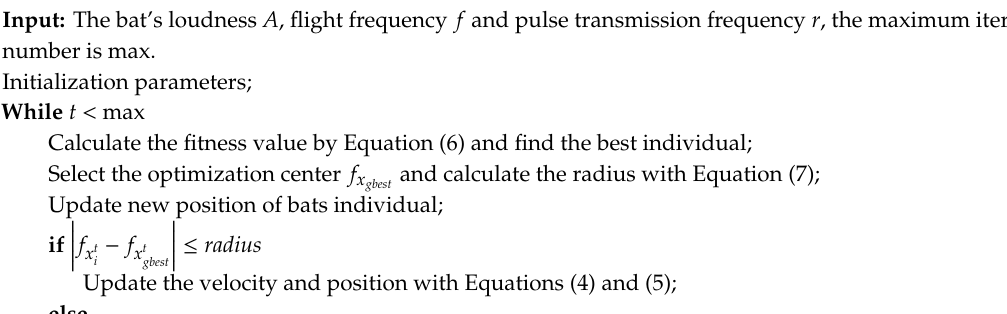
Algorithm 1: Adaptive Bat